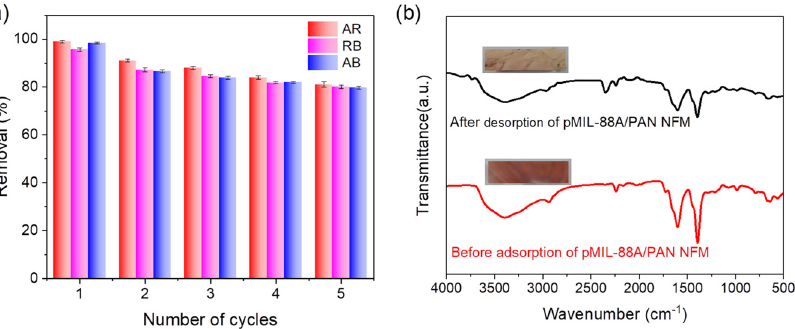
Figure 7. ( a ) Adsorption recyclability of the pMIL-88A/PAN NFM. ( b ) FT − IR spectra of pMIL- 88A/PAN NFM before RB adsorption and after desorption of RB; the inset images are the optical photographs of the corresponding NFMs.